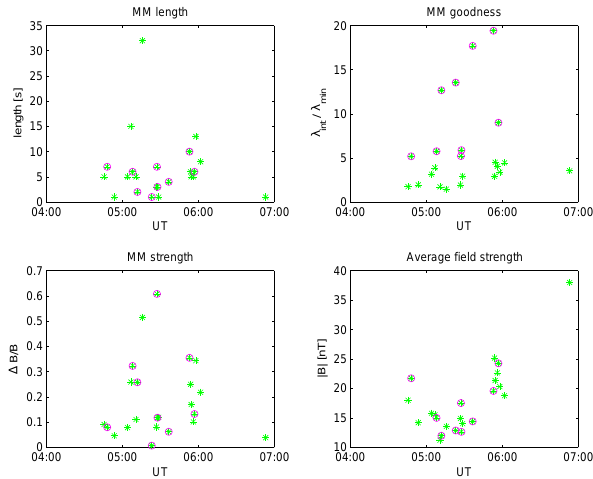
Figure 10. Overview of all MM intervals for the VEGA 2 flyby, in Fig.10. OverviewofallMMintervalsfortheVEGA2flyby,insimilarformatasFig.5. similar format as Fig.